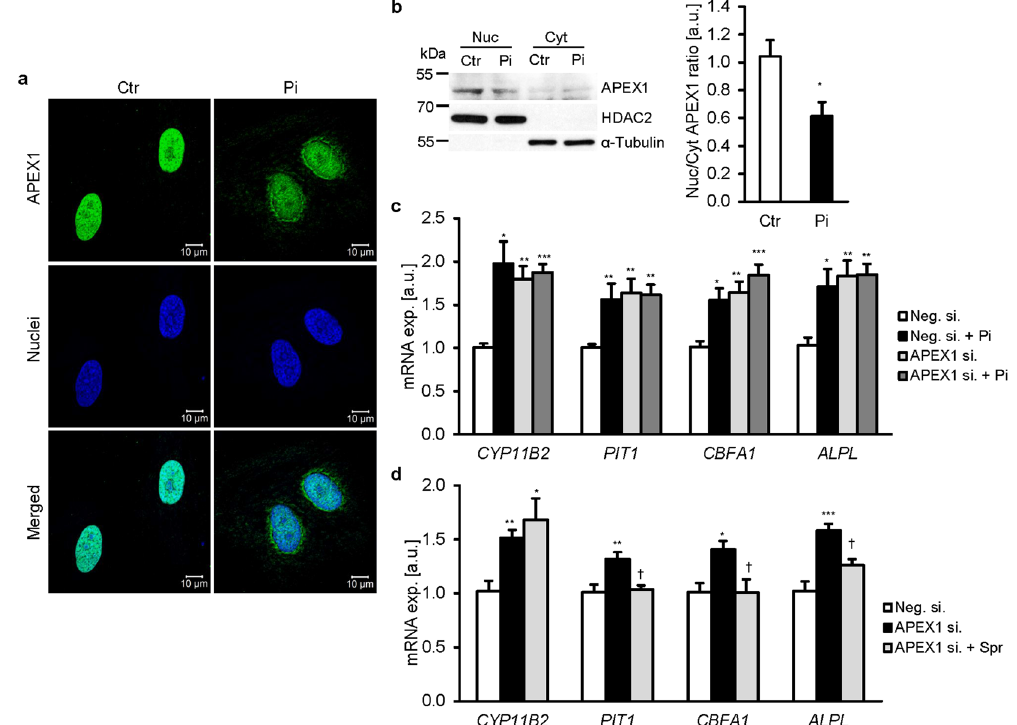
Figure 5. APEX1 represses aldosterone synthase expression in HAoSMCs. ( a ) Representative confocal microscopy images of APEX1 protein expression in HAoSMCs following treatment for 24 hours with (Pi) or without (Ctr) phosphate. Images are representative for four independent experiments. APEX1 expression: green labeling, nuclei: blue labeling. Scale bar: 10 μ m. ( b ) Representative original Western blots and arithmetic means ± SEM (n = 5; arbitrary units, a.u.) of normalized nuclear to cytoplasmic APEX1 protein ratio normalized to HDAC2 and α -Tubulin protein in the nuclear fraction and cytoplasmic fraction respectively, in HAoSMCs following treatment for 24 hours with (Pi) or without (Ctr) phosphate. * (p < 0.05) statistically significant vs. control treated HAoSMCs. Arithmetic means ± SEM (a.u.) of CYP11B2 , PIT1 , CBFA1 and ALPL relative mRNA expression in HAoSMCs silenced for 48 hours with negative control siRNA (Neg.si.) or APEX1 siRNA (APEX1si.) and treated for 24 hours with (Pi) or without (Ctr) phosphate ( c , n = 8) or with or without 10 µ M spironolactone (Spr) ( d , n = 6). * (p < 0.05), ** (p < 0.01), *** (p < 0.001) statistically significant vs. Neg. si. silenced HAoSMCs. † (p < 0.05) statistically significant vs. APEX1si. silenced